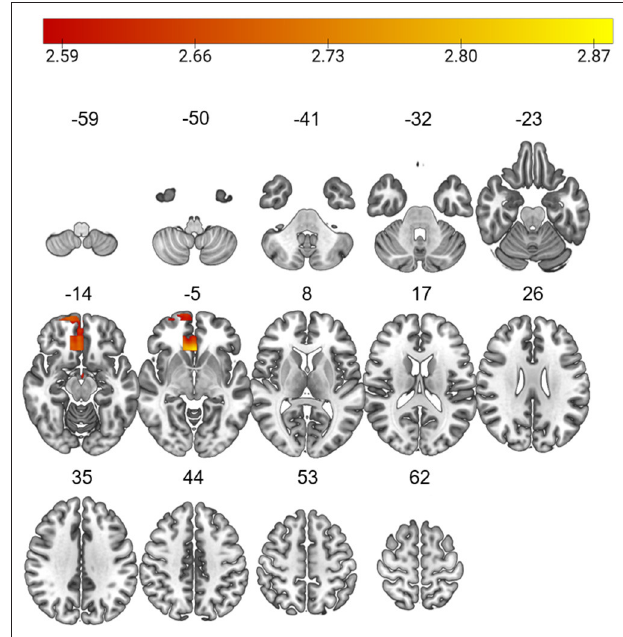
FIGURE 2 | Differences in L-brainAGE between healthy individuals and the cognitively impaired patient subgroup. T -value overlay of statistically significant group differences in L-brainAGE based on a two-sample t -test comparing healthy individuals with the cognitive impaired patients (P FWE < 0.05). The color bar shows regions in which patients with impaired cognition have higher brainAGE compared to healthy individuals. Images are displayed in neurological orientation with MNI coordinates.